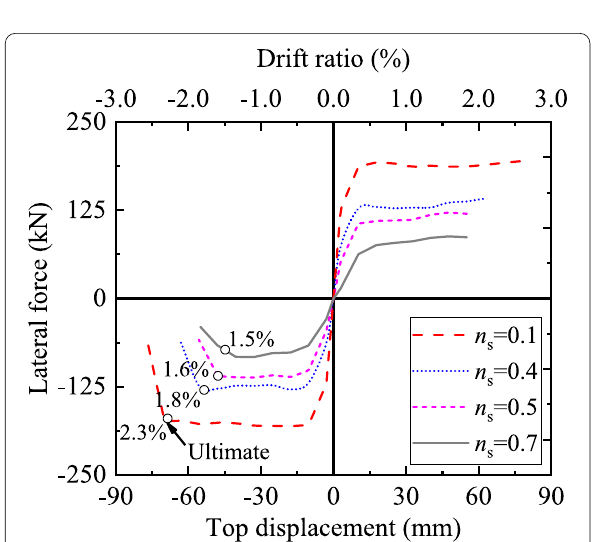
Fig. 12 Skeleton curves of specimens with different normalised reinforcement tensile stress.